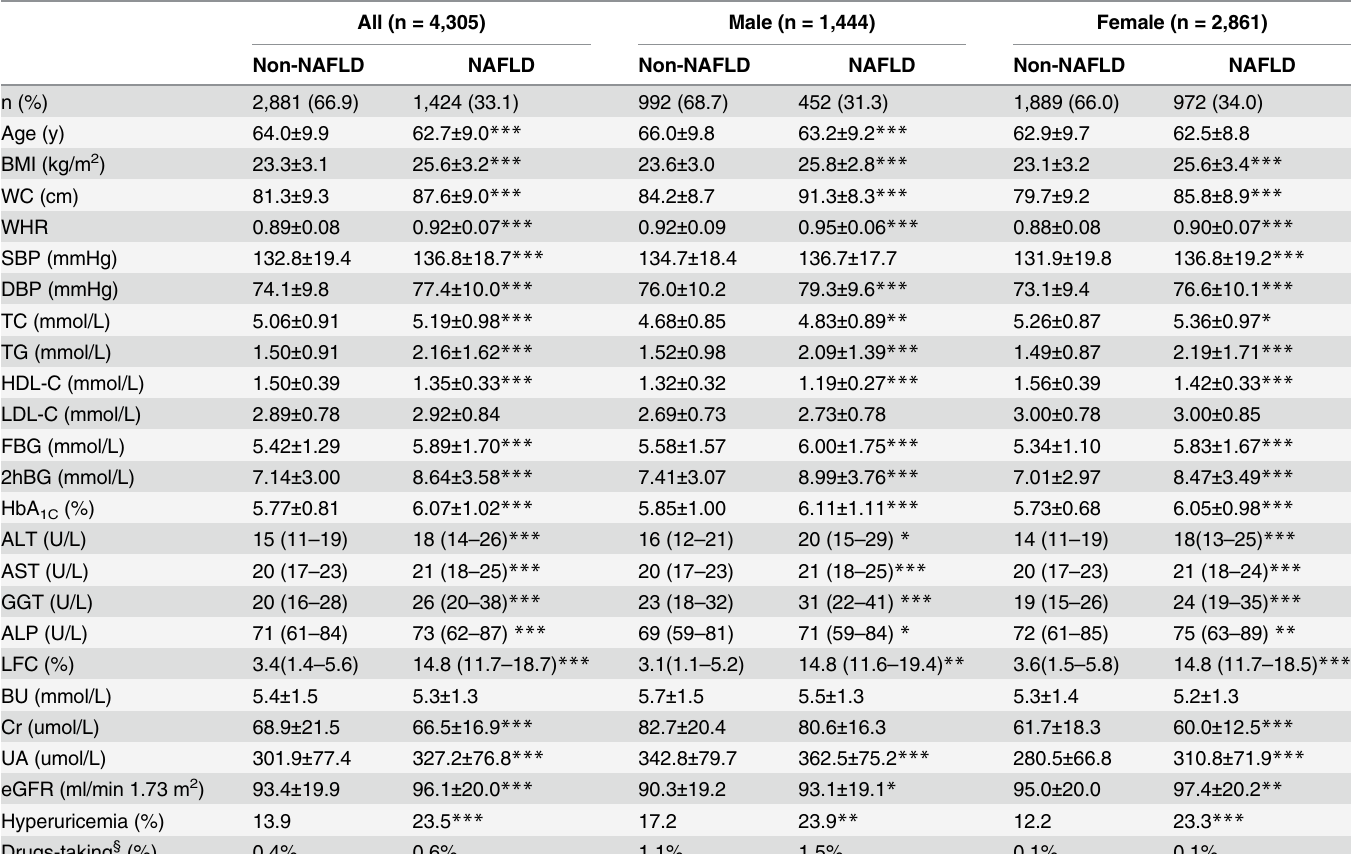
Table 1. Clinical characteristics of the